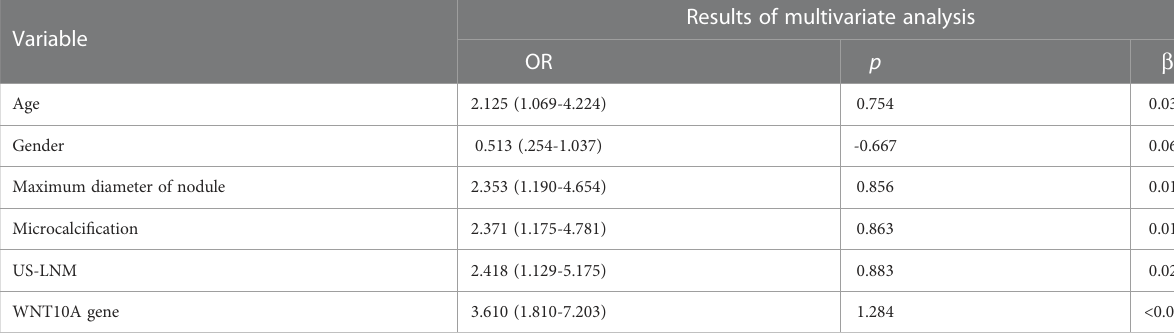
TABLE 2 The results of multivariate